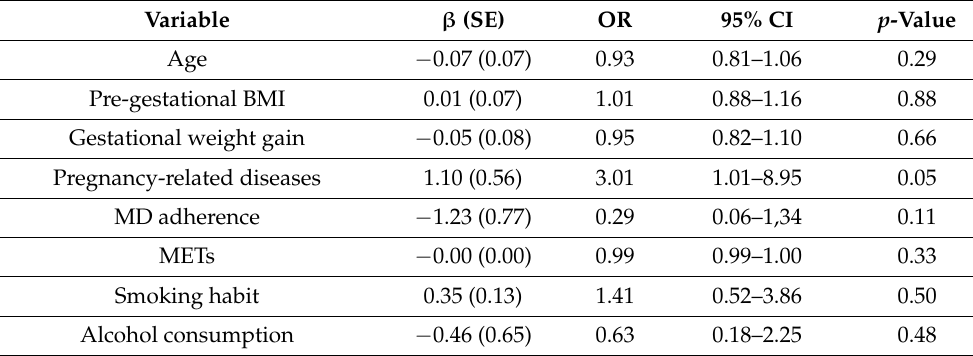
Table 3. Logistic regression analysis. SGA was the dependent variable while maternal demographic, clinical and lifestyle variables were the independent